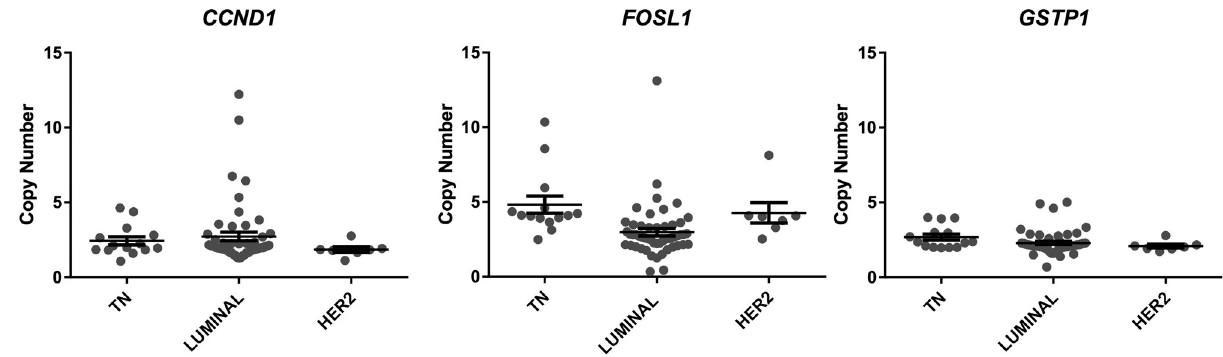
Figure 1 - Copy number alterations (CNAs) of the CCND1 FOSL1 and GSTP1 genes according to the IHC defined breast tumor